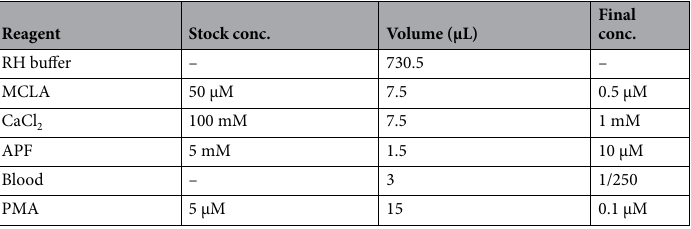
Table 2. Protocol of the measurement for CL-O 2−· and FL-OCl − in blood. The reaction mixture with the final concentrations presented in the table were directly prepared within the fluidic chip. The procedural protocol is shown as step 1 through 9.